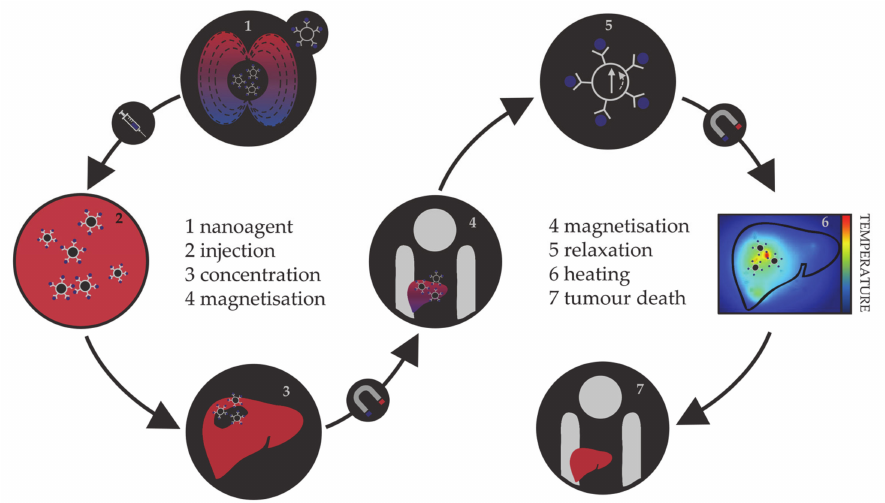
Figure 2. Schematic representation of the principle of magnetic nanoparticle hyperthermia for liver